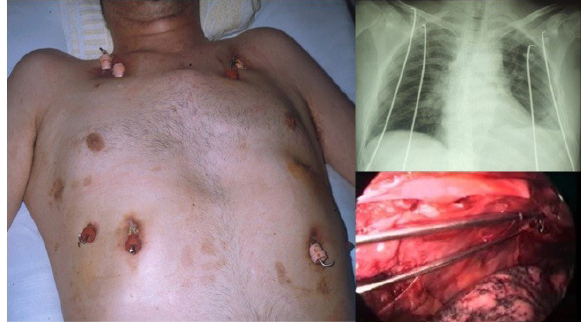
Figure 2. Surgical technique for the stabilization of the anterior flail chest with crossed Kirschner’s wires (videothoracoscopic access).